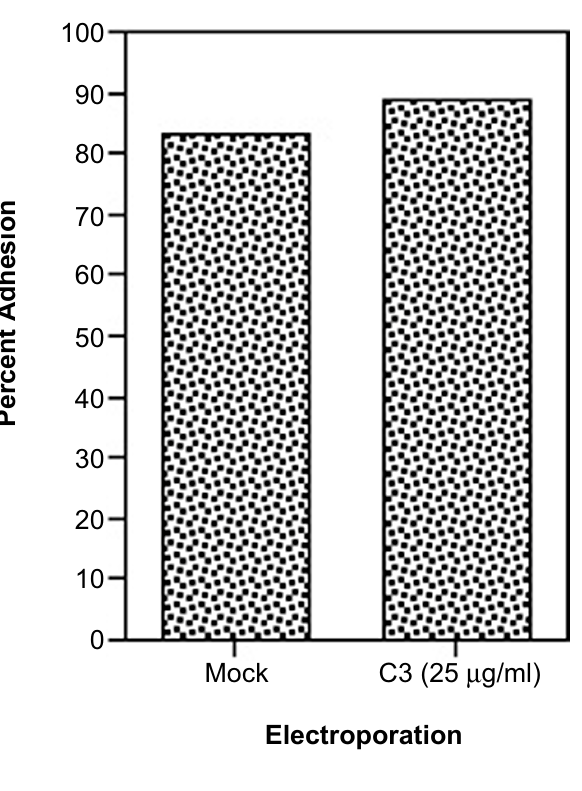
HPB-ALL adhesion to the extracellular matrix component fibronectin. HPB-ALL cells were either electroporated with C3 (25 µ g/ml) or mock electroporated and adhesion to Fn was compared. There was no decrease in the adhesion of C3 treated HPB-ALL cells. The standard deviation was less than